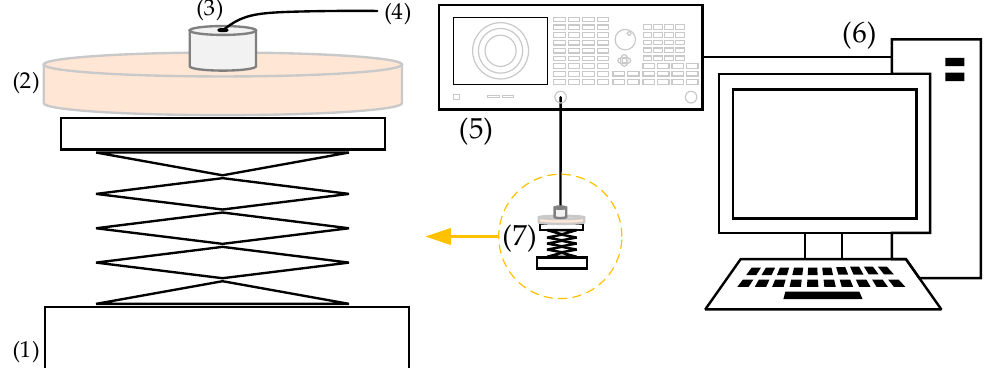
Figure 2. Measurement equipment (1. Laboratory jack, 2. Sample, 3. Open-ended coaxial probe, 4. Coaxial cable, 5.VNA, 6. Computer with software and 7. Measurement setup).